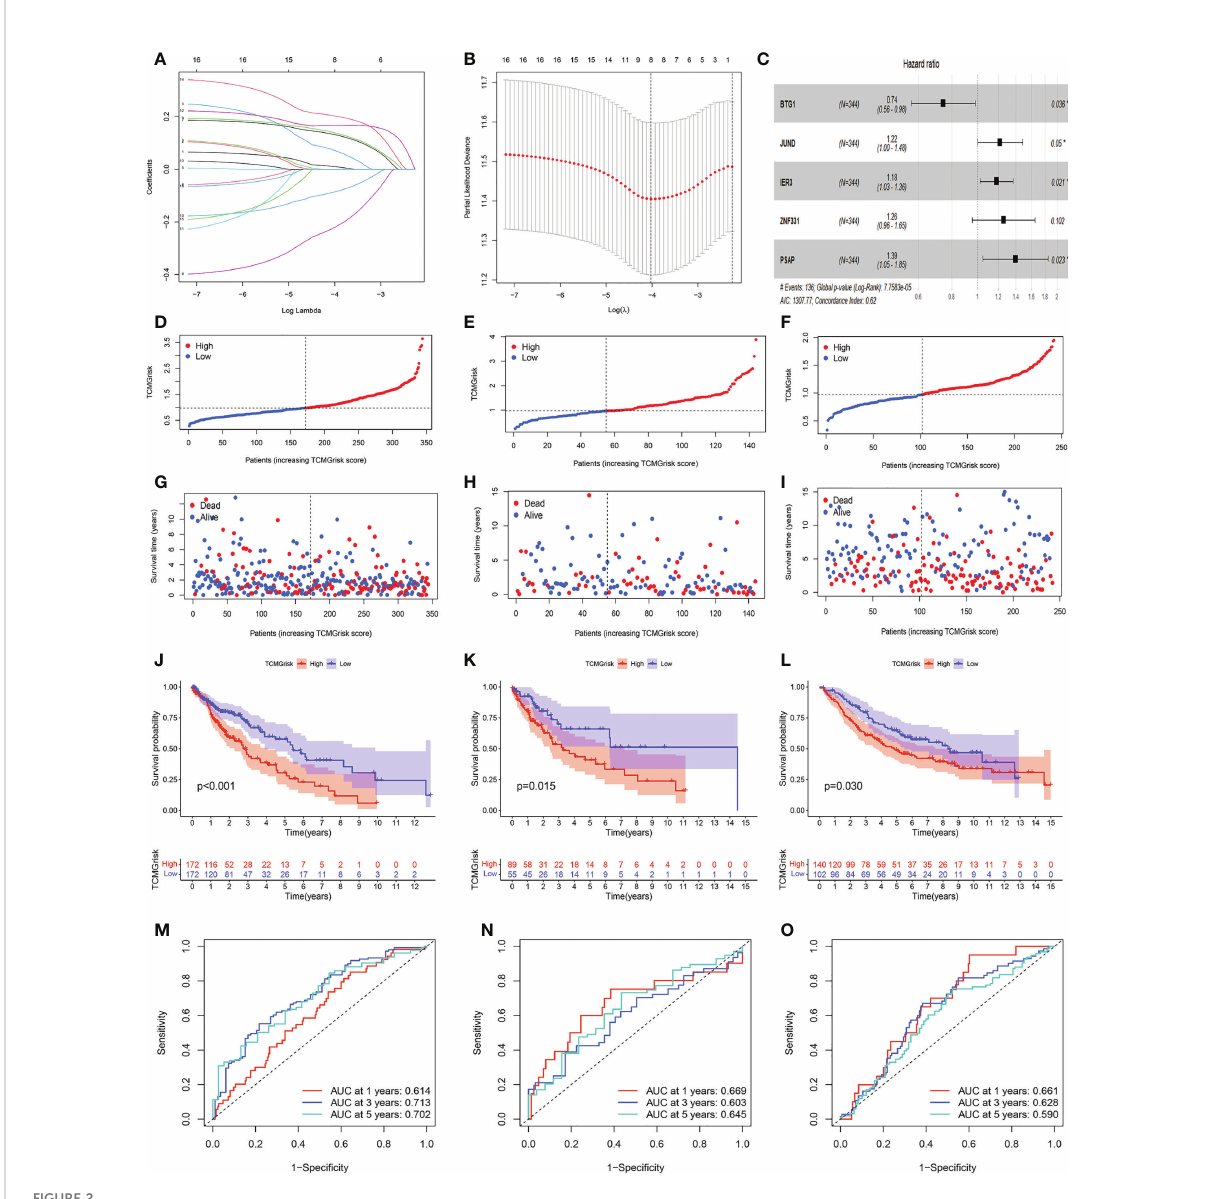
FIGURE 2 Construction and validation of prognostic models. (A, B) LASSO regression analysis. (C) Forest plot of multivariate Cox regression result, * represents P< 0.05. (D – F) Distribution of TCMGrisk score in training cohort, testing cohort and GEO cohort, respective. (G – I) Scatter plot of the OS of each patient in the training cohort, testing cohort and GEO cohort, respective. (J – L) The Kaplan-Meier curves in the training cohort, testing cohort and GEO cohort, respective. (M – O) The AUC at 1-, 3-, and 5-years of prognostic models in the training cohort, testing cohort and GEO